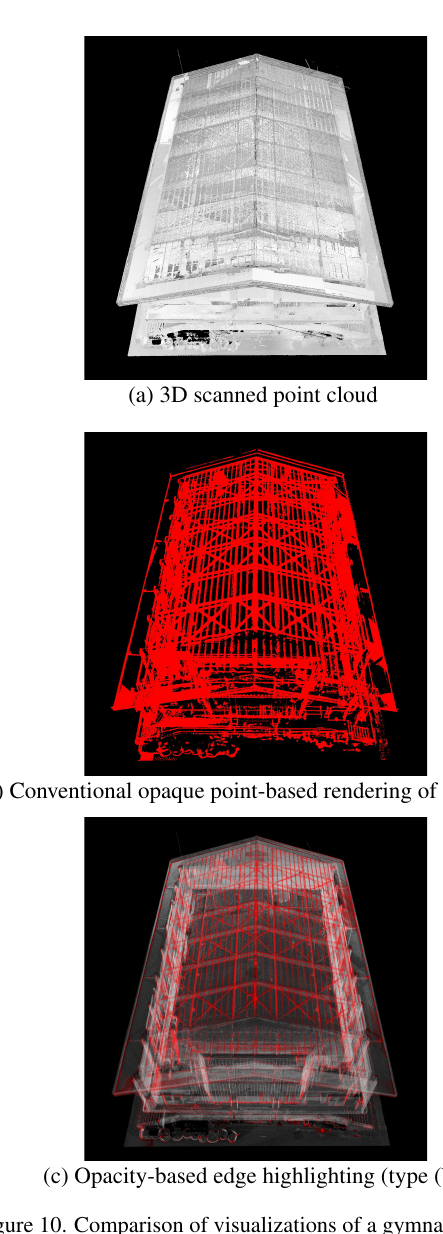
Figure 10. Comparison of visualizations of a gymnasium in an elementary school.